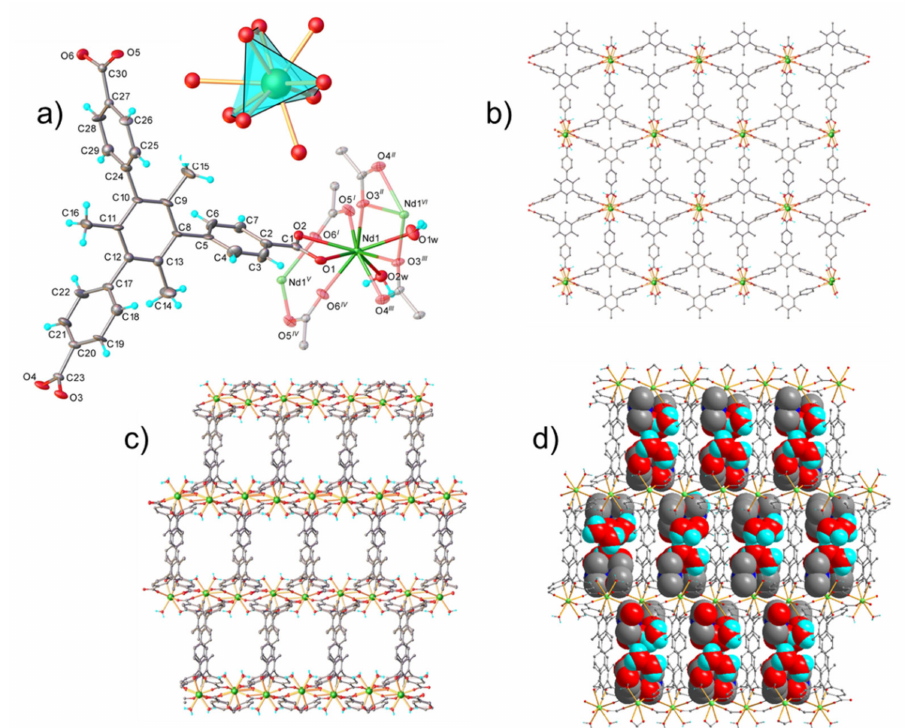
Figure 3. Crystal structure of [NdL(H 2 O) 2 ] · 1.33DMF · 2H 2 O ( 3 ). Extended view of the asymmetric part and coordination environment around the Nd atom in 3 along with the atom labeling scheme and thermal ellipsoids at the 40% probability level. Symmetry generated fragments are drawn with 50% transparency ( a ). Crystal structure packing viewed along the a axis ( b ). View of the crystal structure showing the formation of the channels along the b axis ( c ); with space filling representation of the co-crystallized DMF and H 2 O solvent molecules ( d ). Symmetry codes: I = 0.5 + x , 1.5 − y , 0.5 + z ; II = 0.5 − x , 0.5 + y , 1.5 − z ; III 0.5 + x , 0.5 − y , 0.5 + z ; IV = 0.5 − x , − 0.5 + y , 1.5 − z ; V = 1 − x , 1 − y , 2 − z ; VI − x , 1 − y , 2 − z